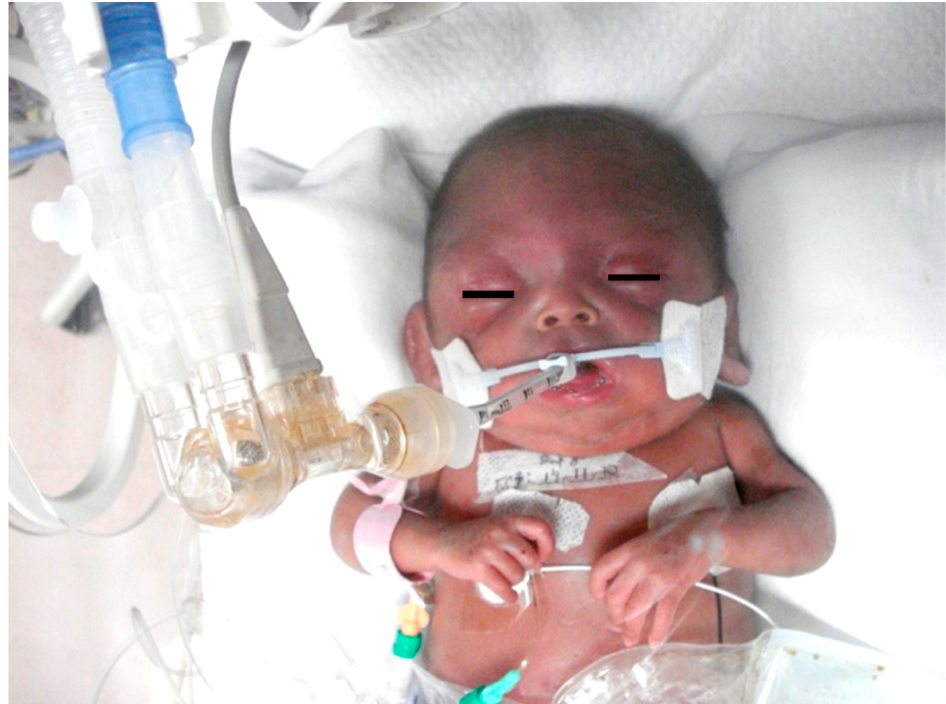
Figure 8. Male of 34 weeks of gestational with multiorgan damage (heart, lungs, liver, gut, and kidneys) after severe perinatal asphyxia. (Courtesy: Dina Villanueva ‐ García, MD, Department of Neonatology, Hospital Infantil de México Federico Gómez).